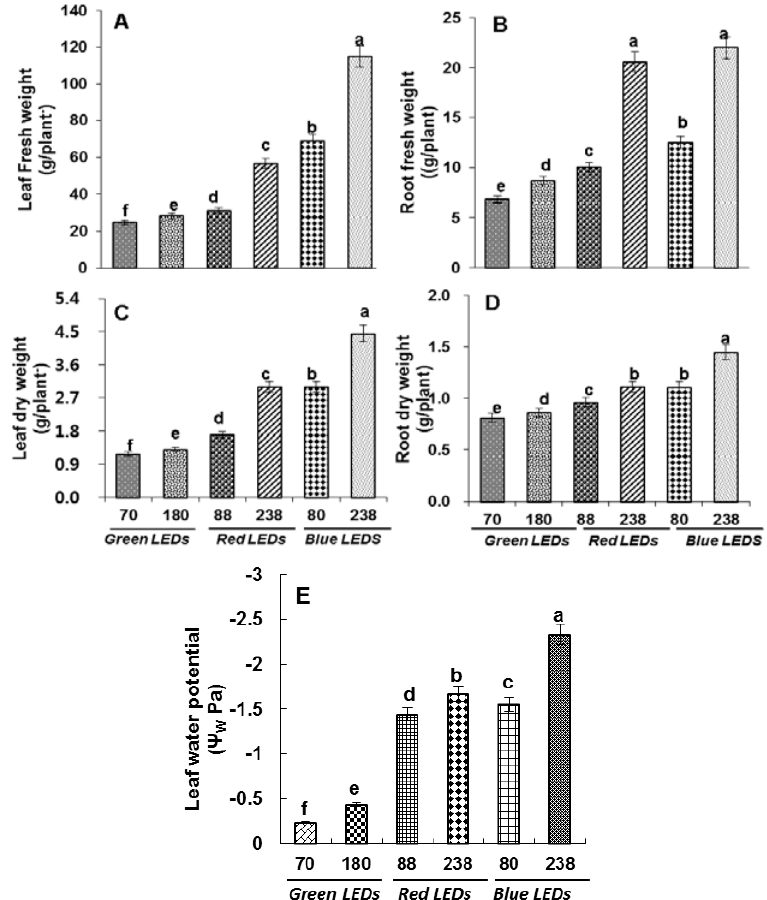
Figure 1. Growth parameters ( A ) Leaf fresh weight; ( B ) Root fresh weight; ( C ) Leaf dry weight; ( D ) Root dry weight and ( E ) Leaf water potential as affected by green, red and blue LEDs at different light intensities—green (70 and 180 μmol m −1 s −1 ), red (88 and 238 μmol m −1 s −1 ) and blue (80 and 238 μmol m −1 s −1 ). Vertical bars indicate ± SE of the means for n = 5. Means denoted by the different letter are significantly different at p < 0.05 according to the Tukey’s studentized range